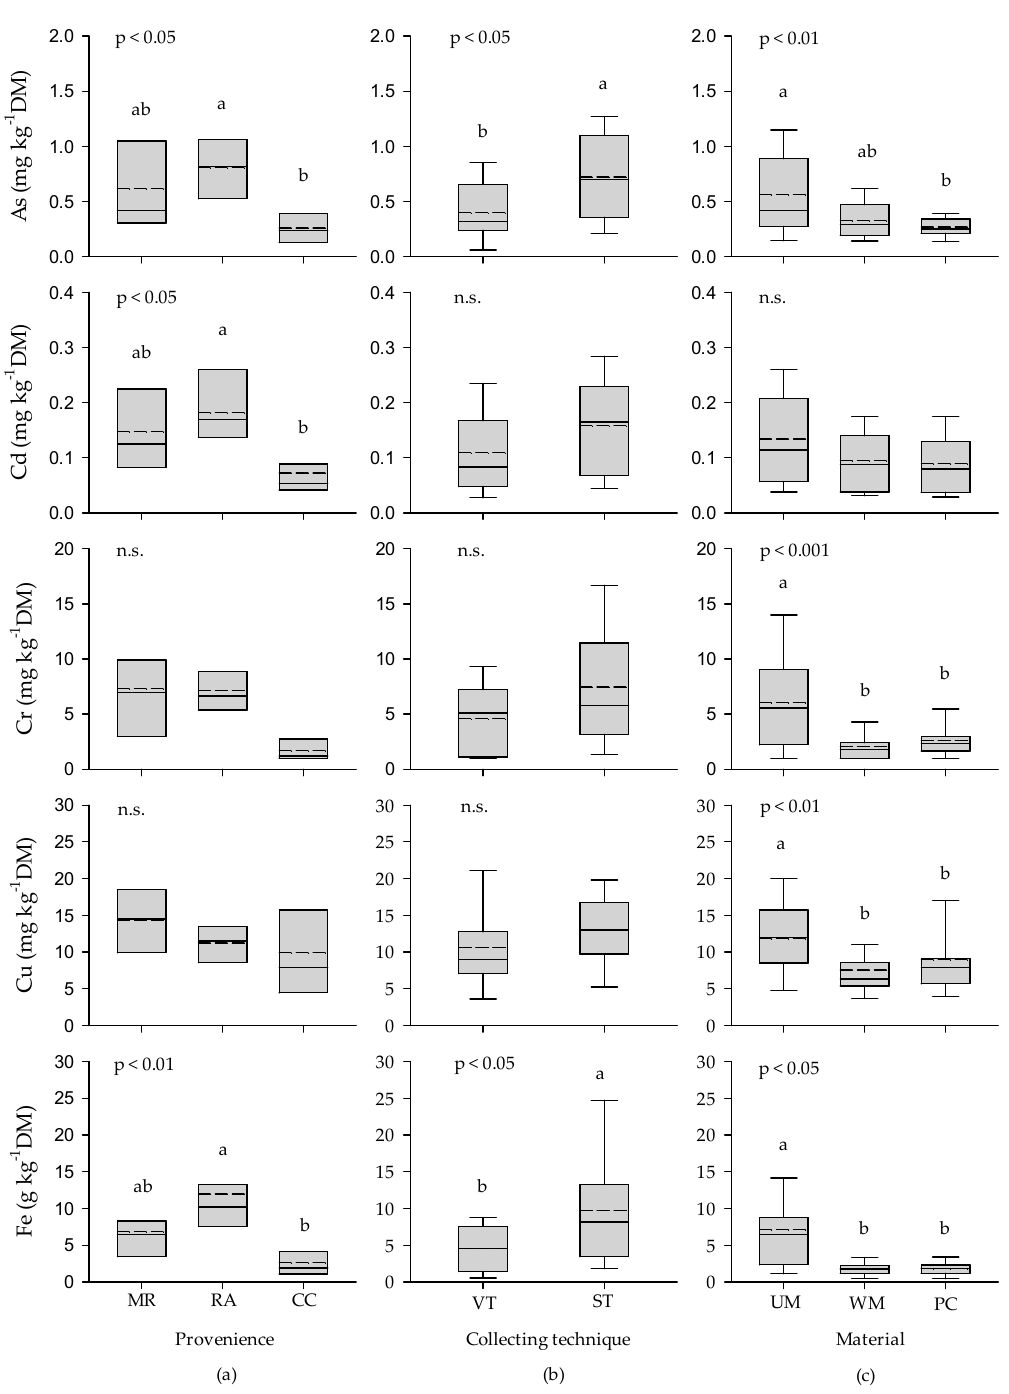
Figure 1. Concentration of heavy metals As, Cd, Cr, Cu and Fe in leaf litter of urban street trees from ( a ) various provenience (main road—MR, residential area—RA, city center—CC) collected by ( b ) different technique (vacuum—VT and sweeping technique—ST) and ( c ) with various degrees of material processing (unwashed material—UM, washed material—WM, press cake—PC). Whiskers indicate the 5th and 95th percentiles. Dashed lines indicate median values. Different letters indicate significant differences; n.s., not significant. Samples with values below the analytical detection limit were included into the dataset, using the detection limit as a conservative estimate of the concentration.